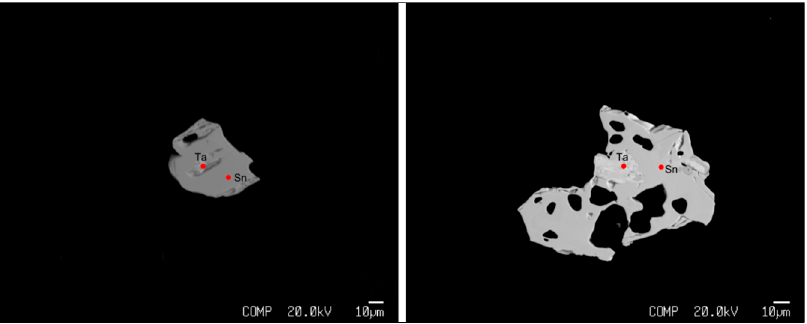
Figure 14. Cassiterite grains analysed by EPMA, that show Ta-rich compositions.